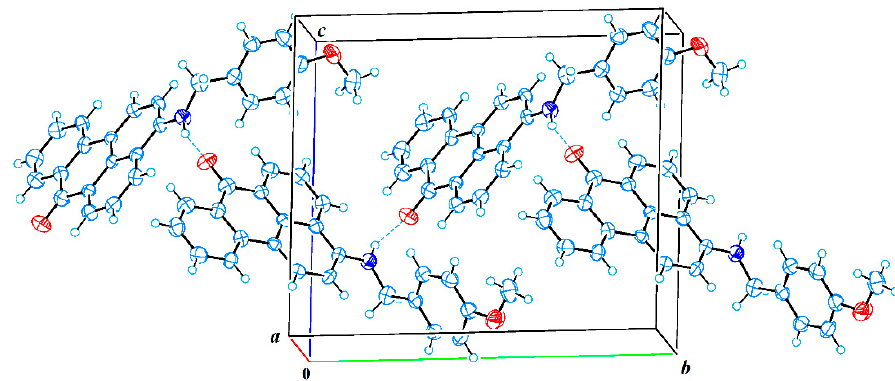
Figure 2. Formation of the molecular chain in the crystals 3 .